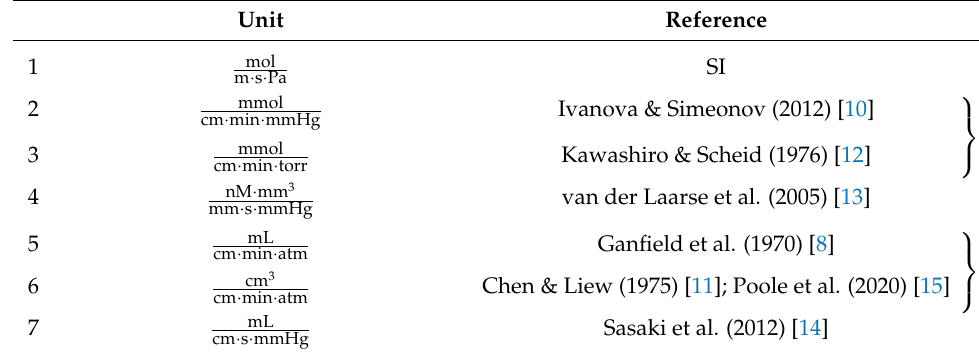
Table 1. Selection of non-SI units for oxygen Krogh coefficient appearing in the physiology literature. The numerator represents quantity of gas, e.g., (mmol O 2 ), (mL O 2 ), (cm 3 O 2 ), etc. Bracketed rows of the table indicate equivalent